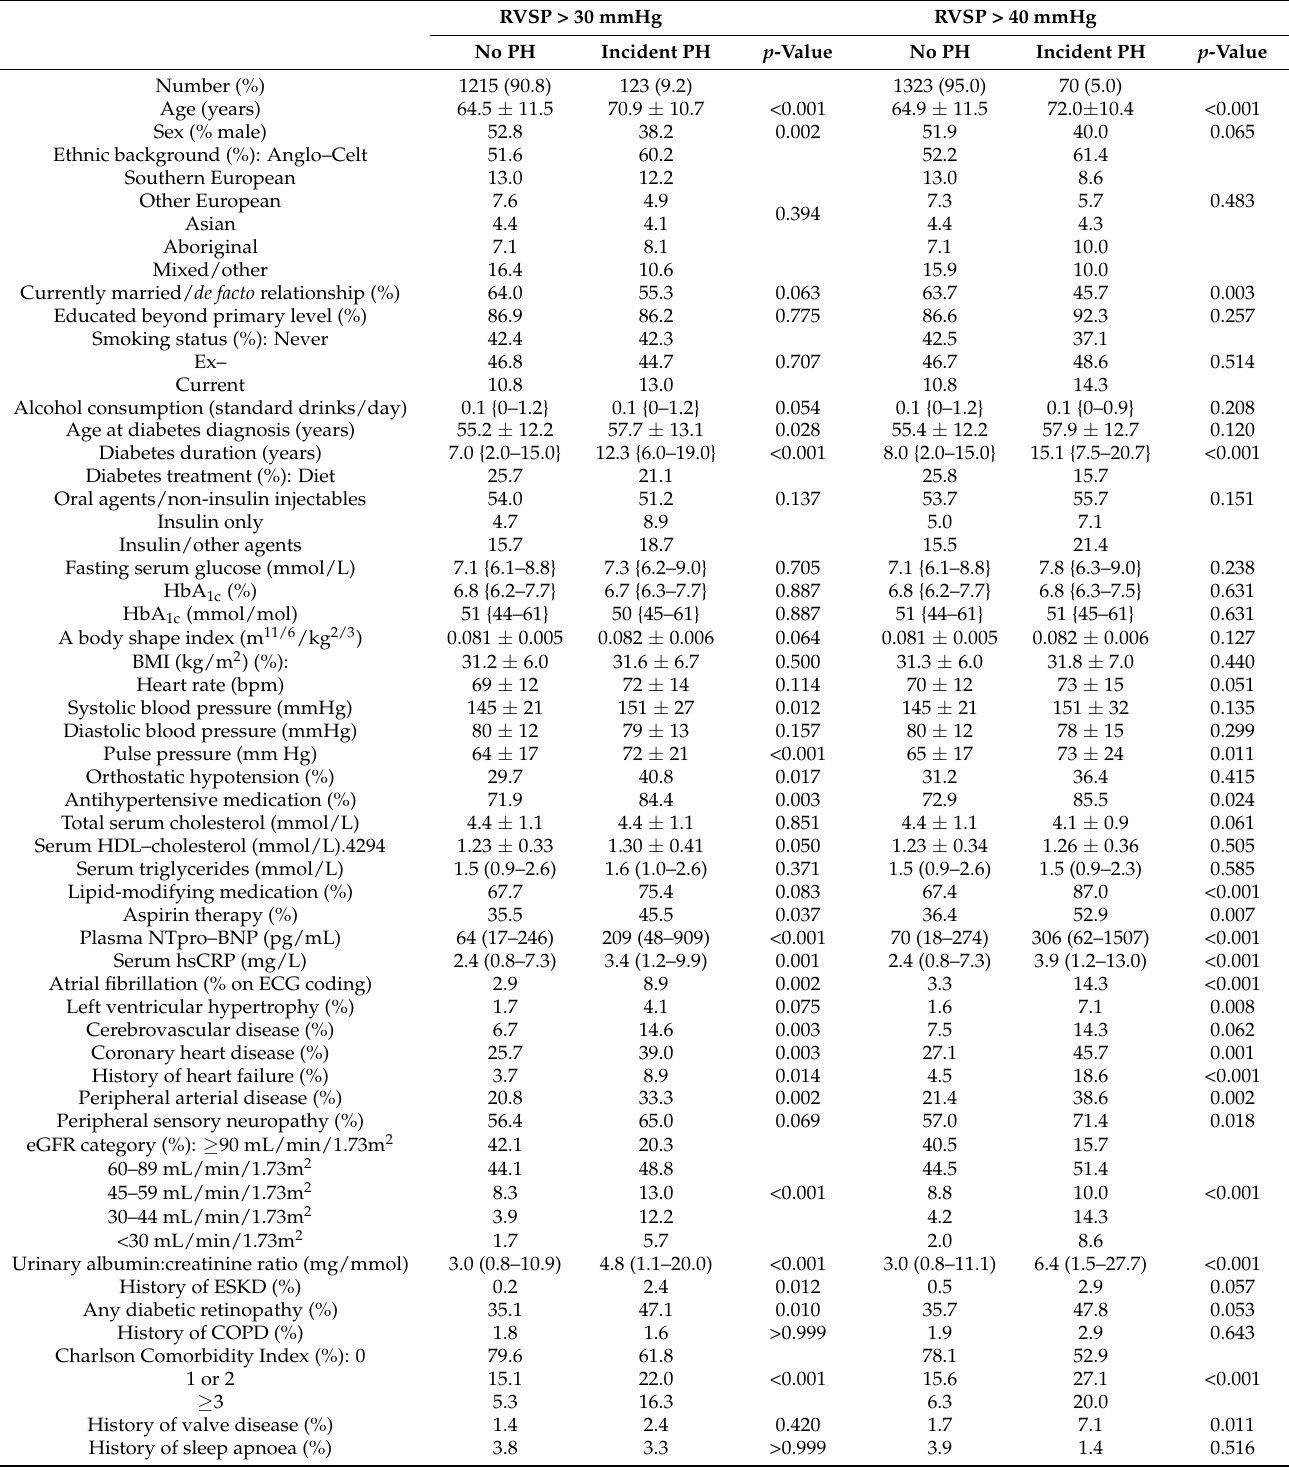
Table 3. Baseline characteristics of type 2 diabetes participants without prevalent pulmonary hypertension (PH) by incident PH status to end of December 2016. Data are percentages, mean ± SD, geometric mean (SD range) or median {interquartile